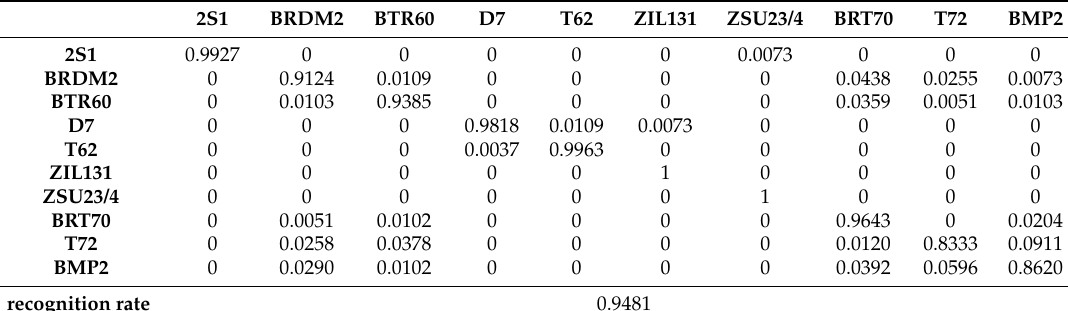
Table 15. The result of sparse representation classifier (SRC) based on SAR-HOG under